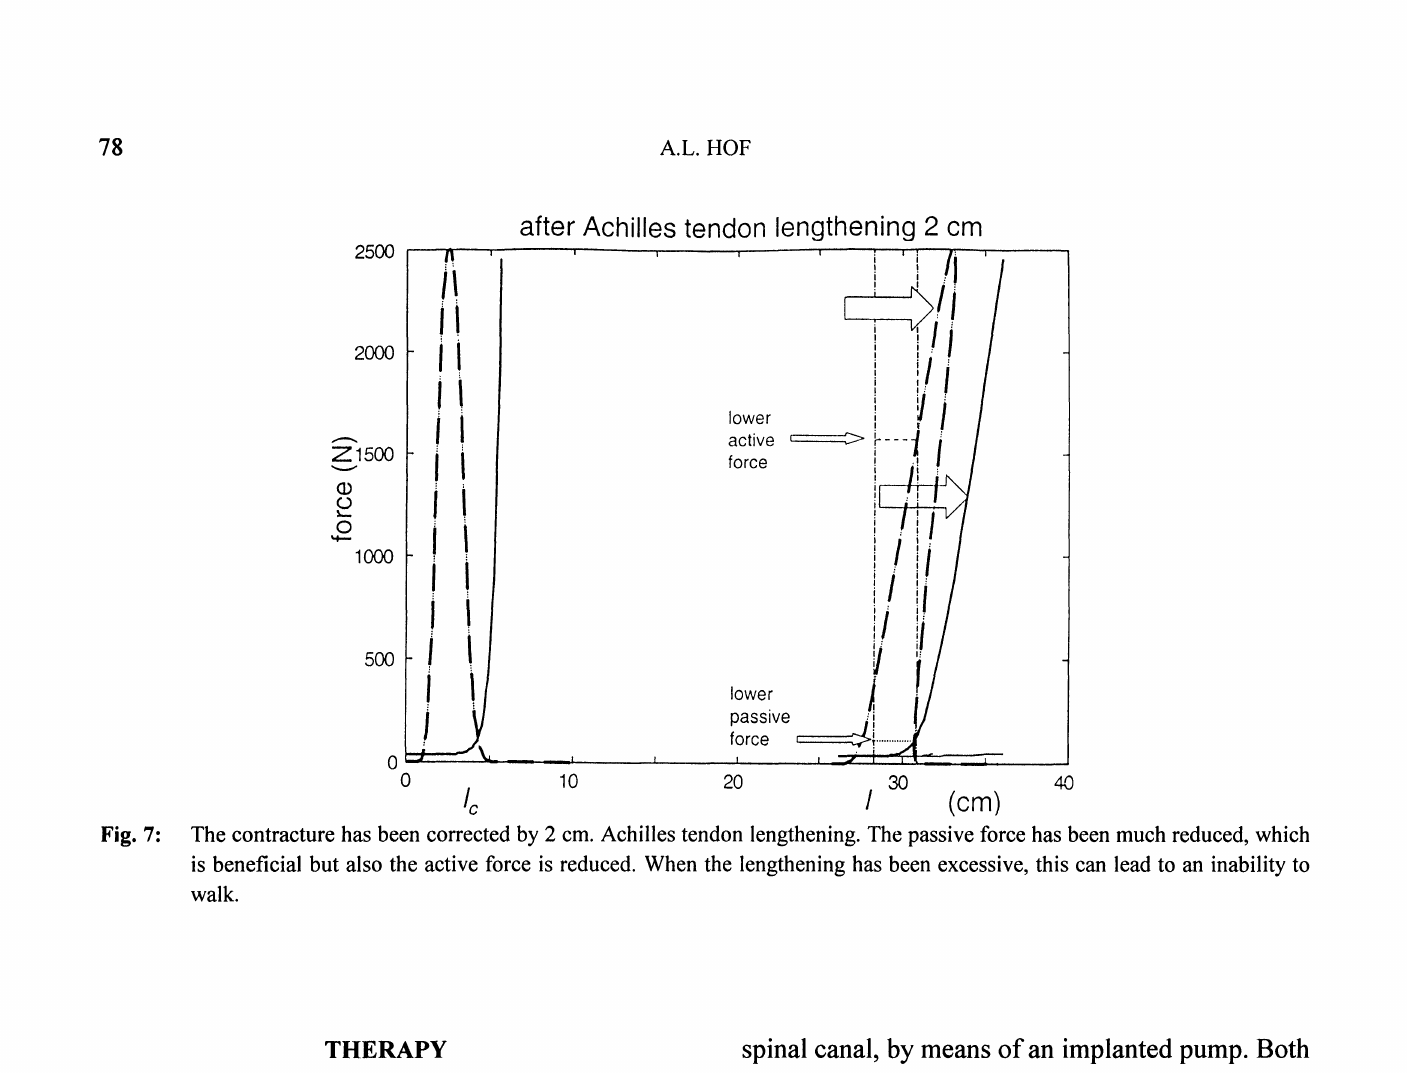
after Achilles tendon lengthening 2 cm 2500